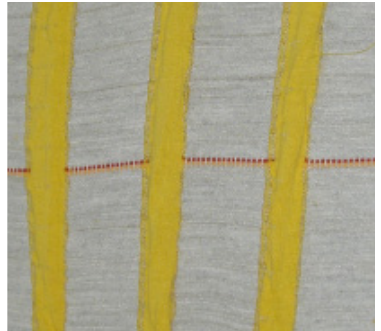
Figure 4. Structure of the fabric